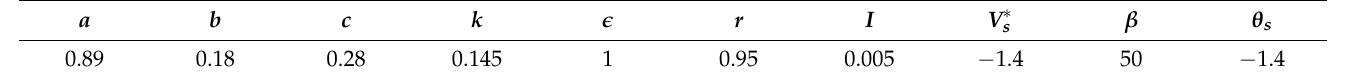
Table 3. The value of parameters for two coupled